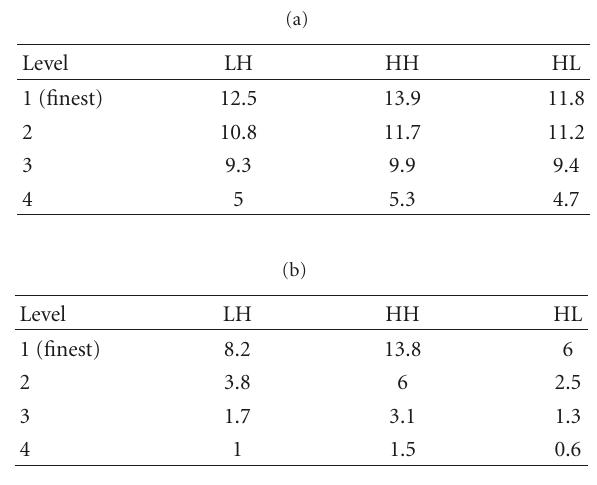
Table 6: (a): MNDL threshold, (b): BayesShrink threshold of subbands for Cameraman and σ w =